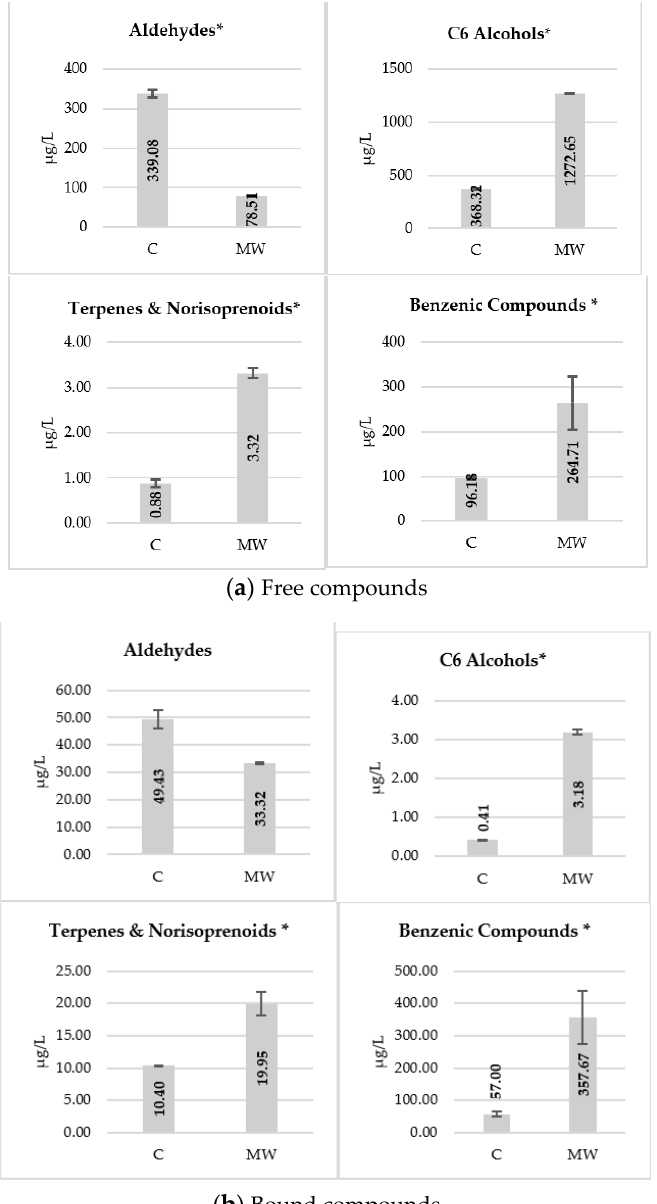
Figure 1. Mean concentrations (μg/L) of the main groups of free ( a ) and bound compounds ( b ) in control must (C) and must from microwave-treated grapes (MW). *: denote significant differences according to Student’s t-test ( p ≤ 0.05).